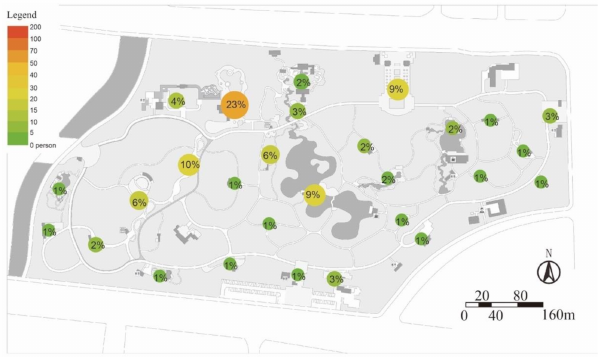
Figure A12. Spatial distribution of average total number of users per hour in Zhujiang Park.